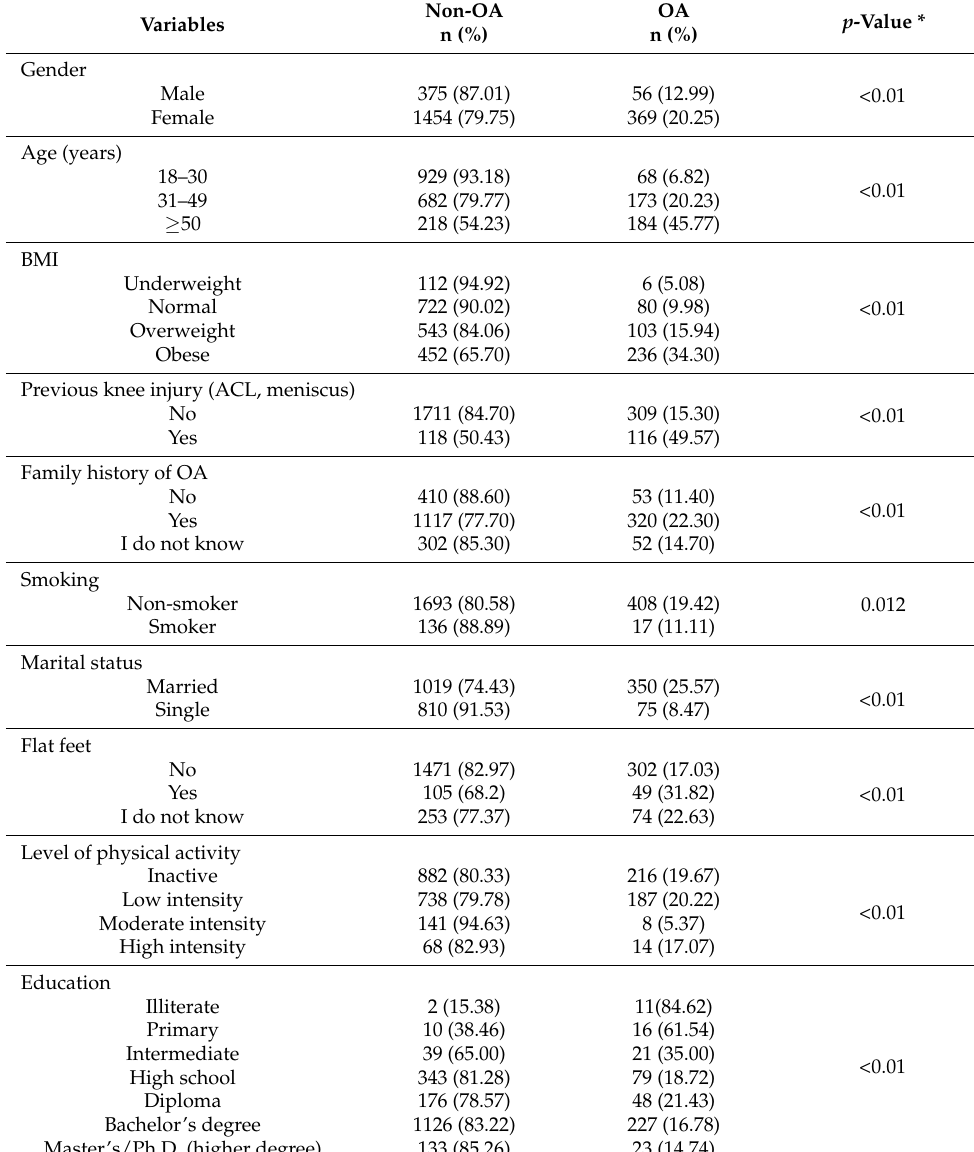
Table 3. The prevalence and association of knee OA with different